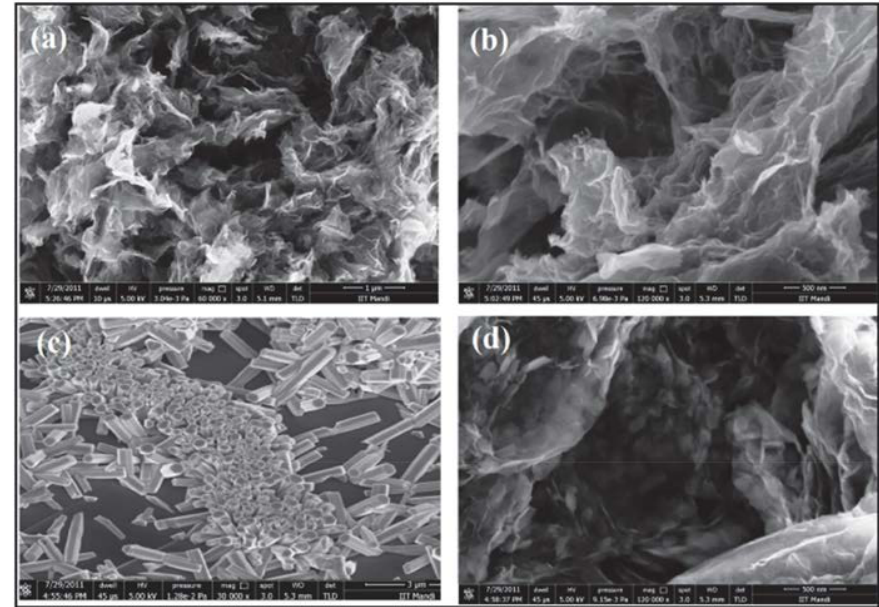
Figure 6. SEM micrographs of (a) GO (b) NG (c) ZnO (d) ZNG-4.